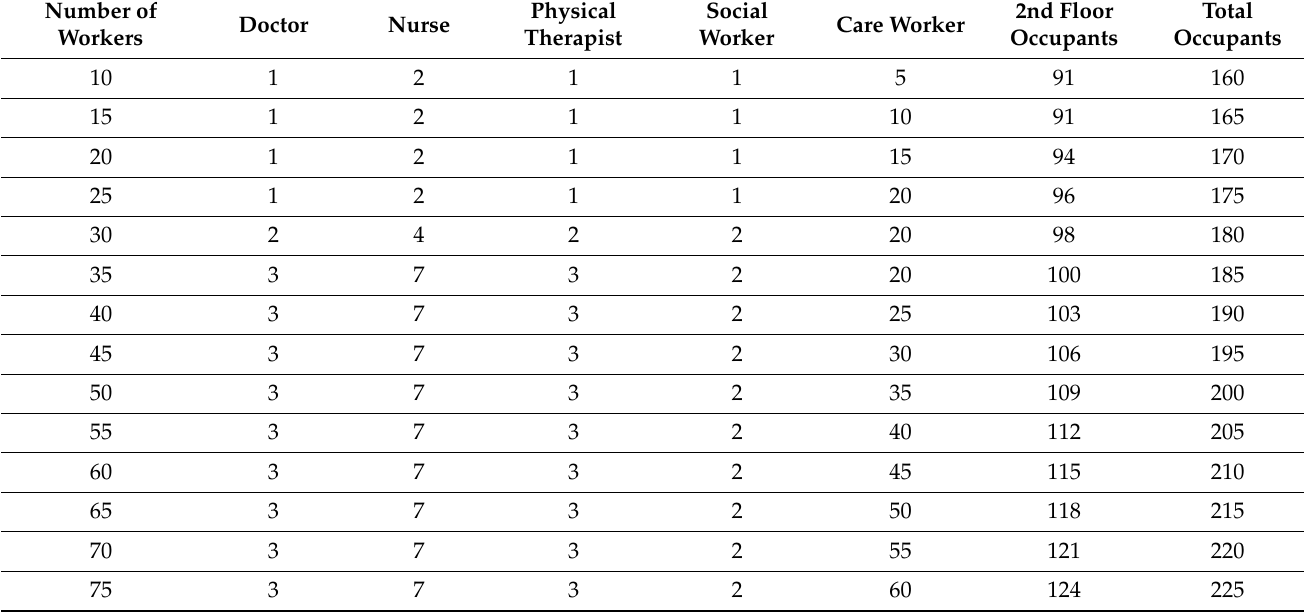
Table 6. Number of